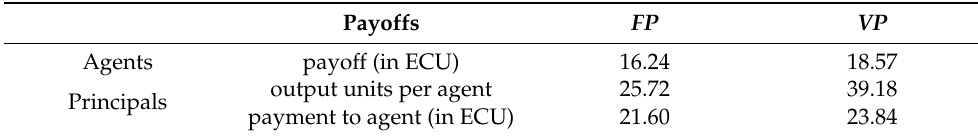
Table 7. Mean utilities by